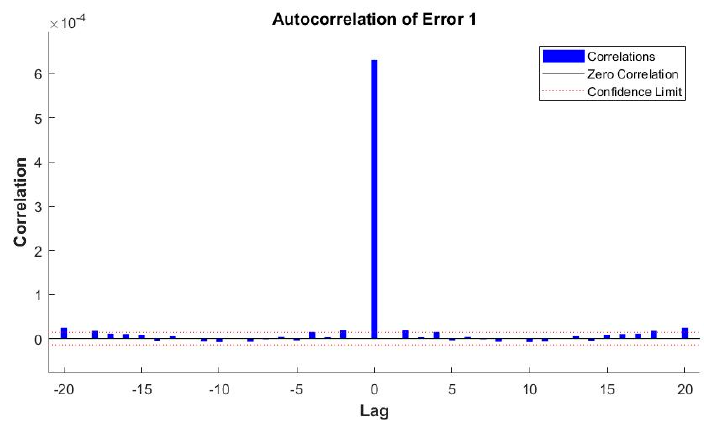
Figure 8. The error autocorrelation function when forecasting the electricity consumption for the month of December, using the ANN_NAR_BR network.